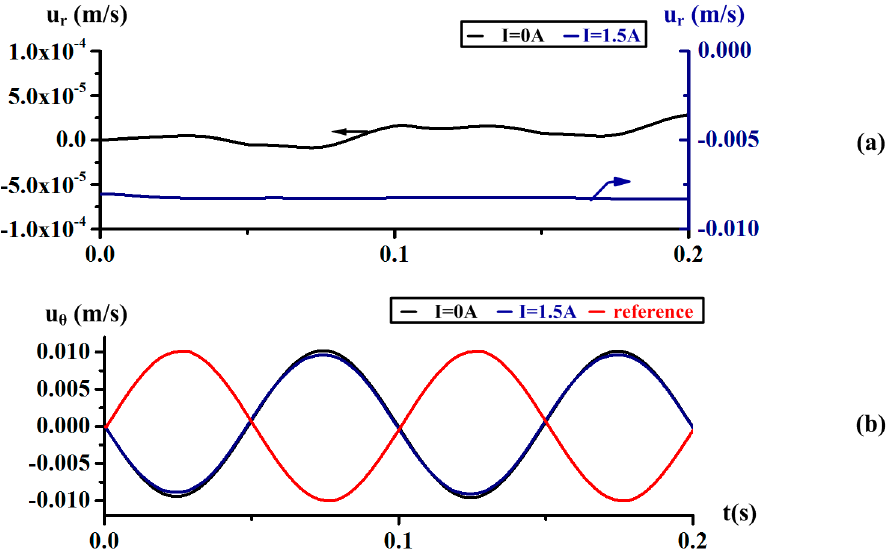
Figure 11. The radial velocity u r and relative circumferential velocity u θ of the test point P (0.010, 0, − 0.001) in the sensing channel under an energized current I = 0 A and I = 1.5 A at the frequency f = 10 Hz.